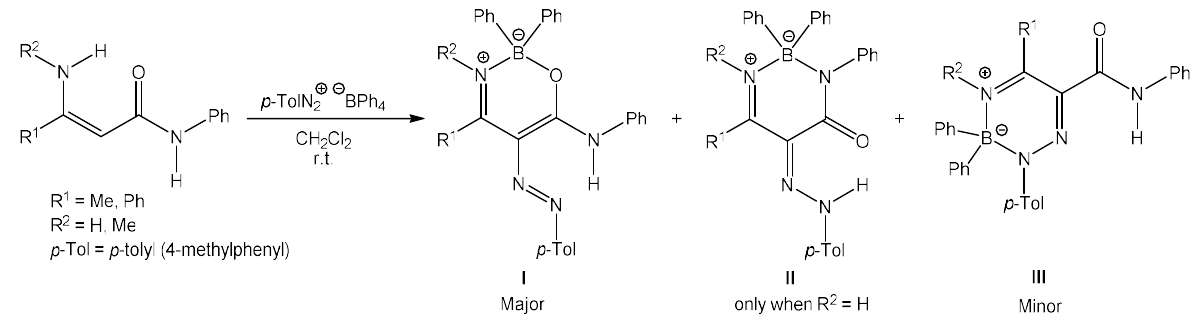
Figure 1. General structure of simple